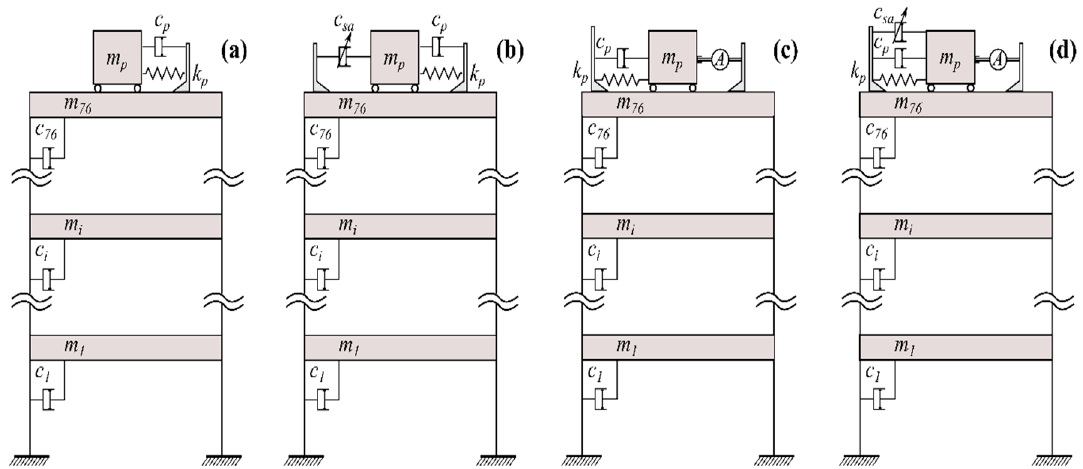
Figure 11. Ensemble of all the different control options ( a ) TMD; ( b ) STMD; ( c ) ATMD; ( d ) SHMD studied herein for the model 76-storey structure of Yang et al. [3].